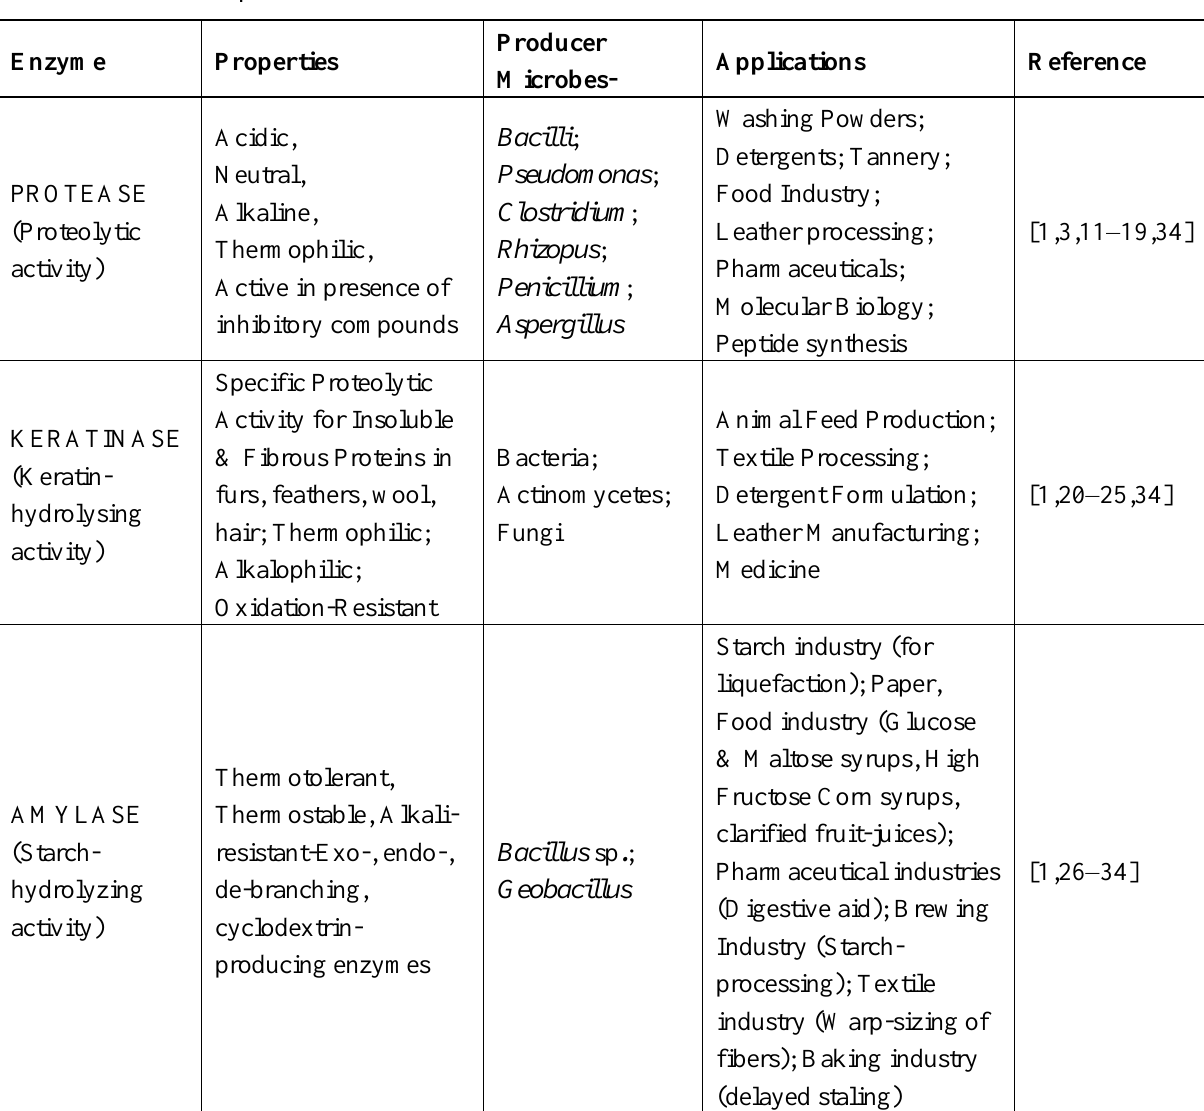
Table 1. A summarized overview of some microbial enzymes with special characteristics of industrial